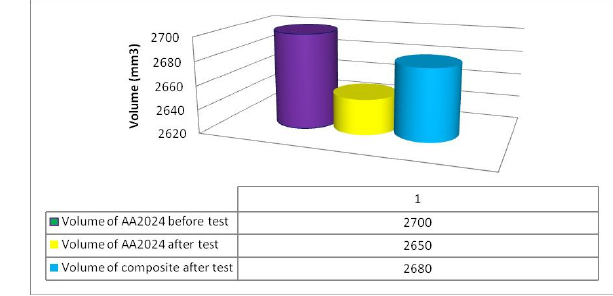
Figure 12: Thermal expansion behavior of hybrid composite at optimum reinforcement parameters of the hybrid composite after the thermal expansion was found to be 2680 mm 3 , which is